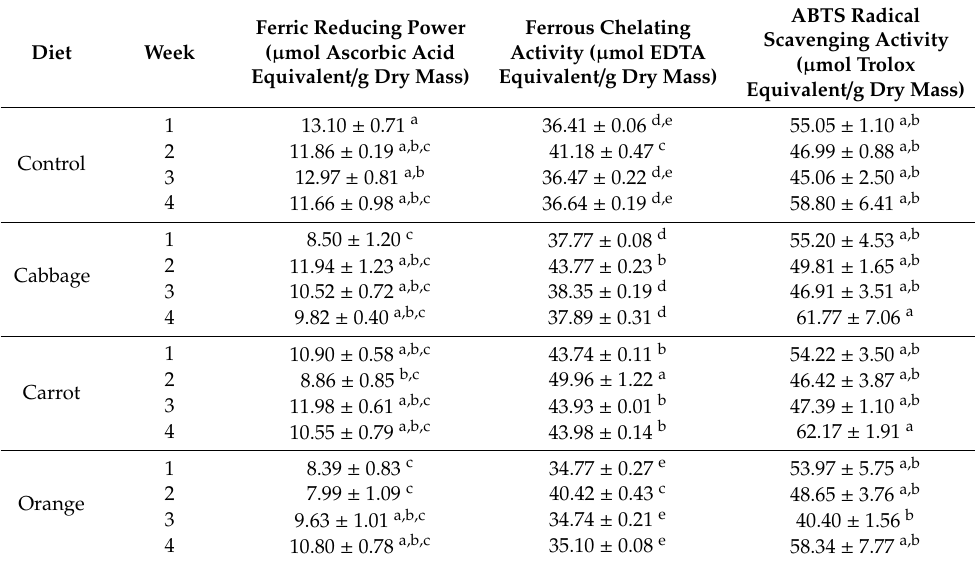
Table 1. Antioxidant activity of mealworm larvae fed on di ff erent diets over four